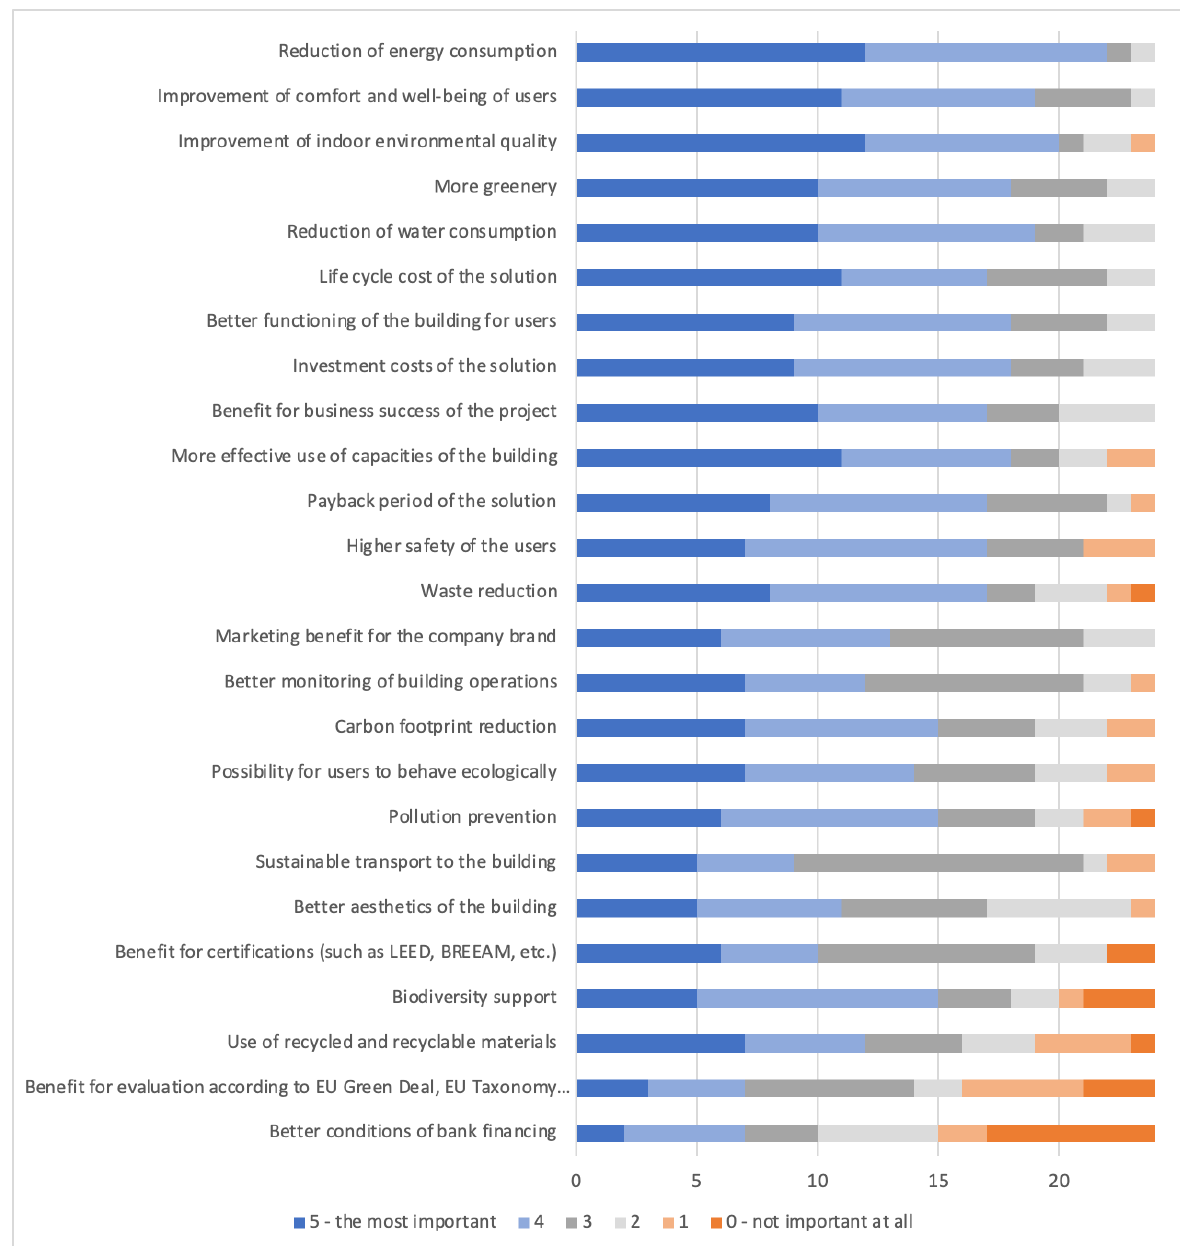
Figure 2: Distribution of ratings by the experts for each criterion (source: